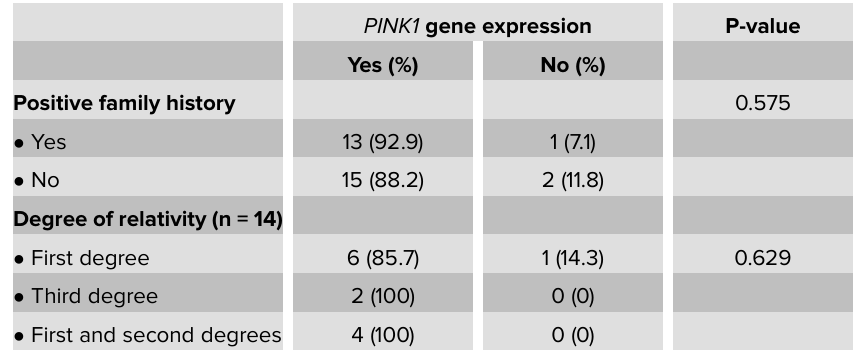
Table 6: Shows the association between PINK1 gene with affected family